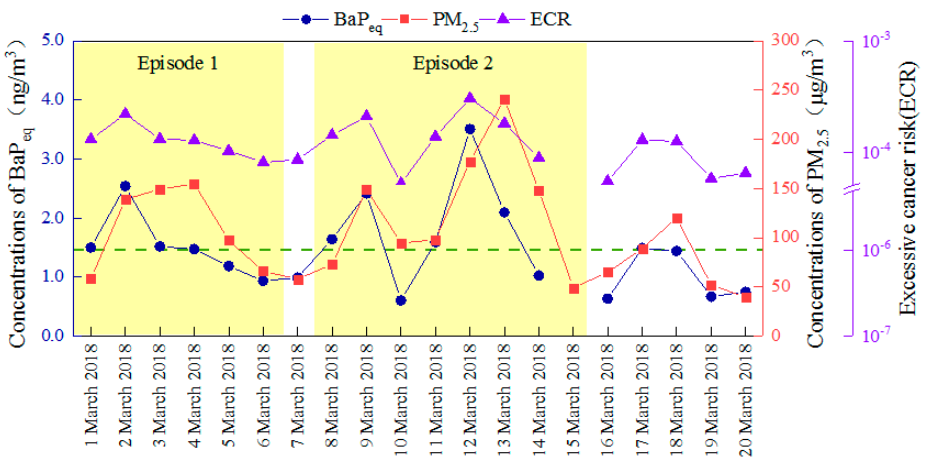
Figure 9. Variation of BaPeq, PM 2.5 , and excessive cancer risk (ECR) in the study area during the monitoring period.